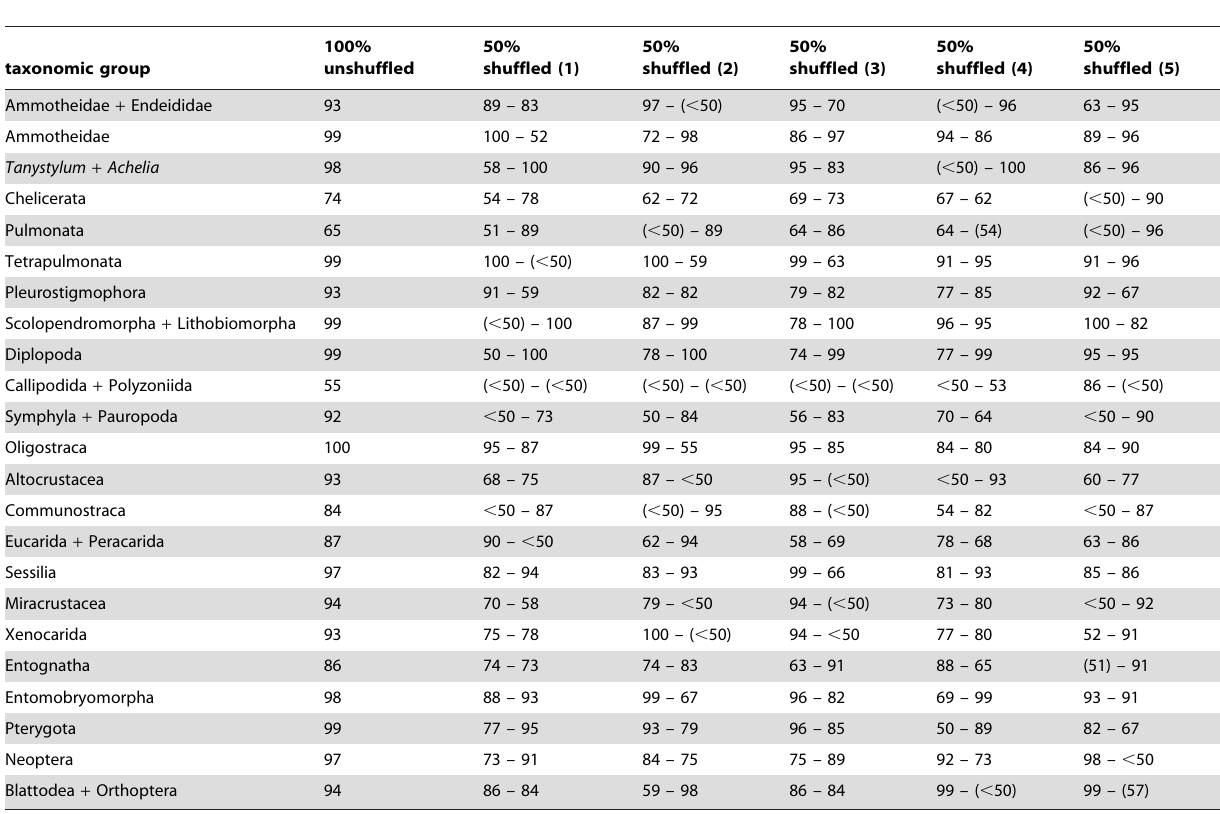
Table 2. Highly variable bootstrap values for selected taxa upon analysis of shuffled, half-sized data matrices. a